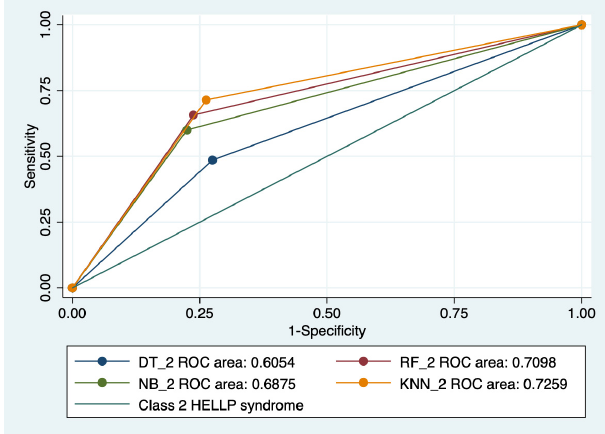
Figure 7. Multiple ROC curves comparison between different machine learning models for class 2 HELLP syndrome. Legend: ROC—Receiver operating characteristic; DT—decision trees; NB—na- ïve Bayes; KNN—k-nearest neighbors; RF—random forest.